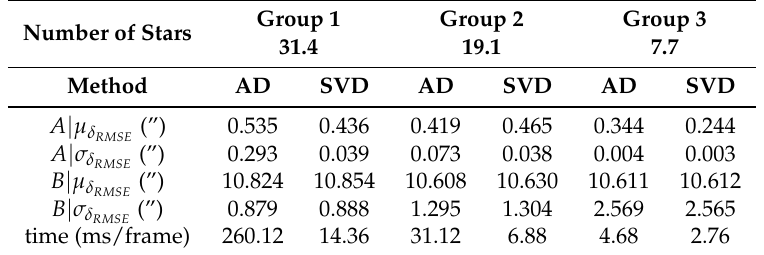
Table 4. Calibration results of the comparison experiment. AD, angular